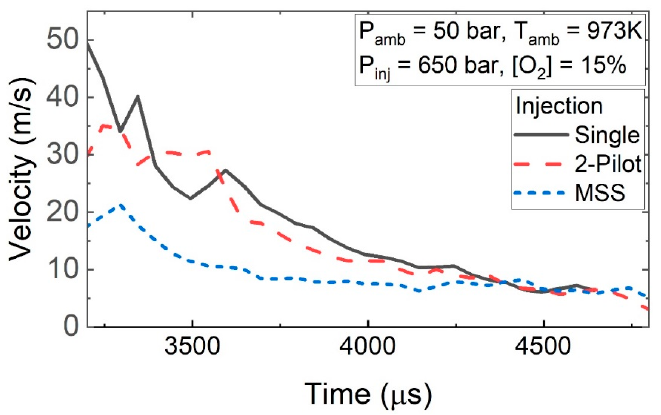
Figure 9. Flame penetration profiles of single, two-pilot, and MSS injection strategies.